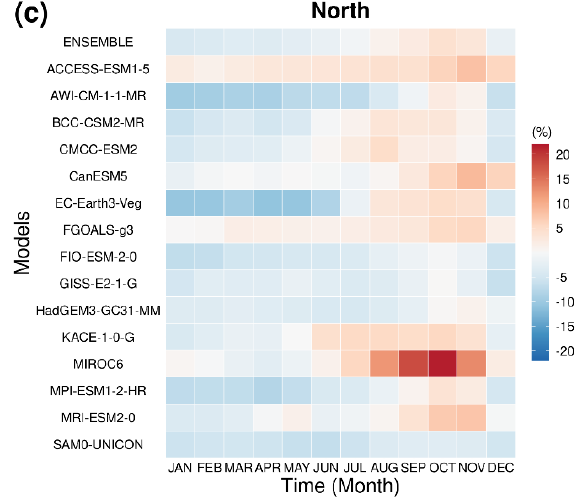
Figure 5. Annual cycle of mean surface air temperature over subregions ( a ) East Coast, ( b ) Interior, and ( c ) North of the NEB, based on the reference period (1980–2014).